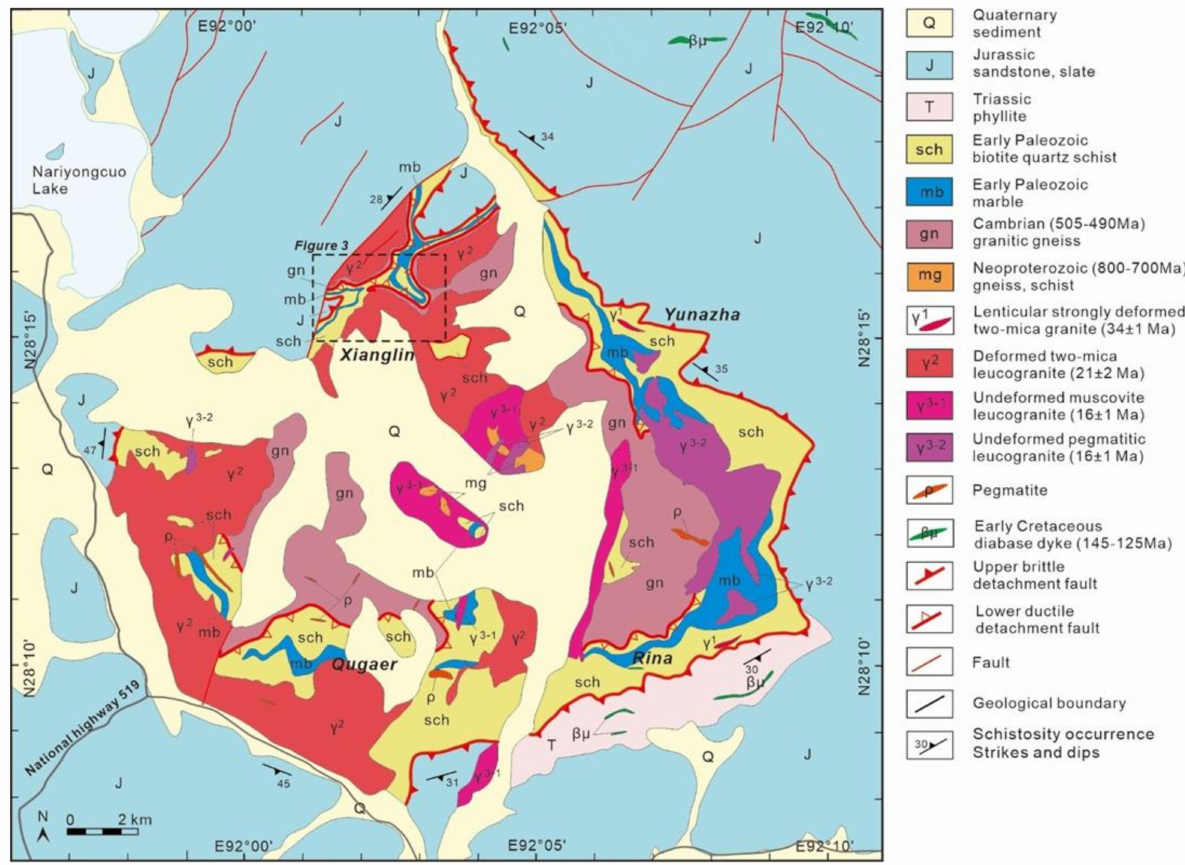
Figure 2. Geological map of the Cuonadong dome